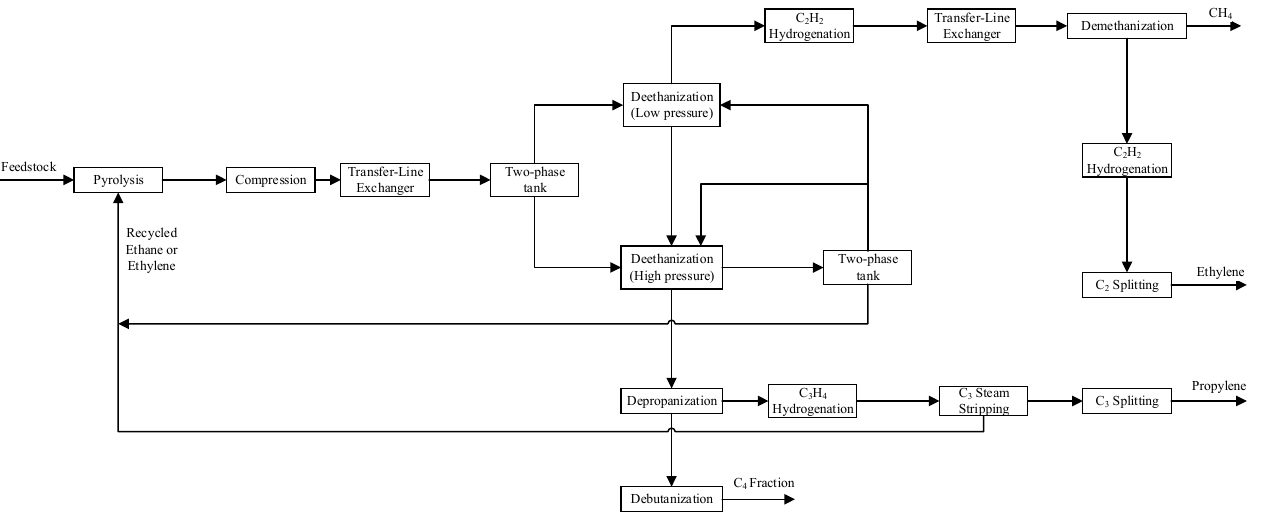
Figure 9. Flow chart of ethylene production process. Table 7. Ten measured variables in ethylene production process.